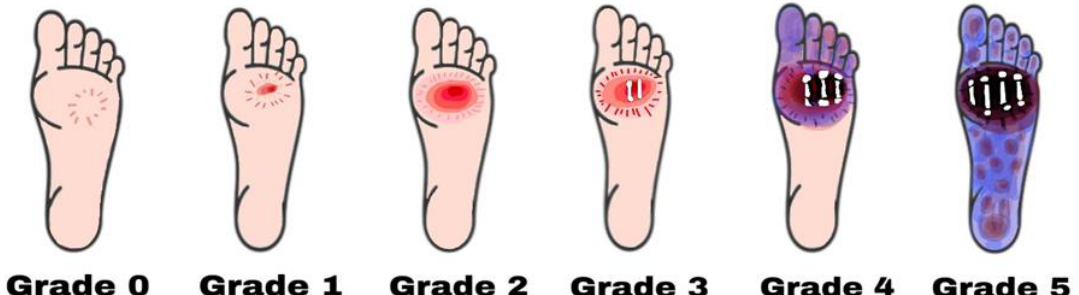
bone deformity prominent in some aspects; absence of abscess or osteomyelitis; Grade Three: Presence of osteomyelitis, deep abscess, or tendinitis; severe infection symptoms (e.g., redness, heat, and swelling); Grade four: Gangrene (dry, wet, infected, or non-infected) in toe or forefoot; surgical ablation of the foot required with minimal blood supply for below-knee amputations; Grade five: Gangrene spreads to the whole foot; no healing signs; amputation below the knee is strongly recommended [28,45,46].